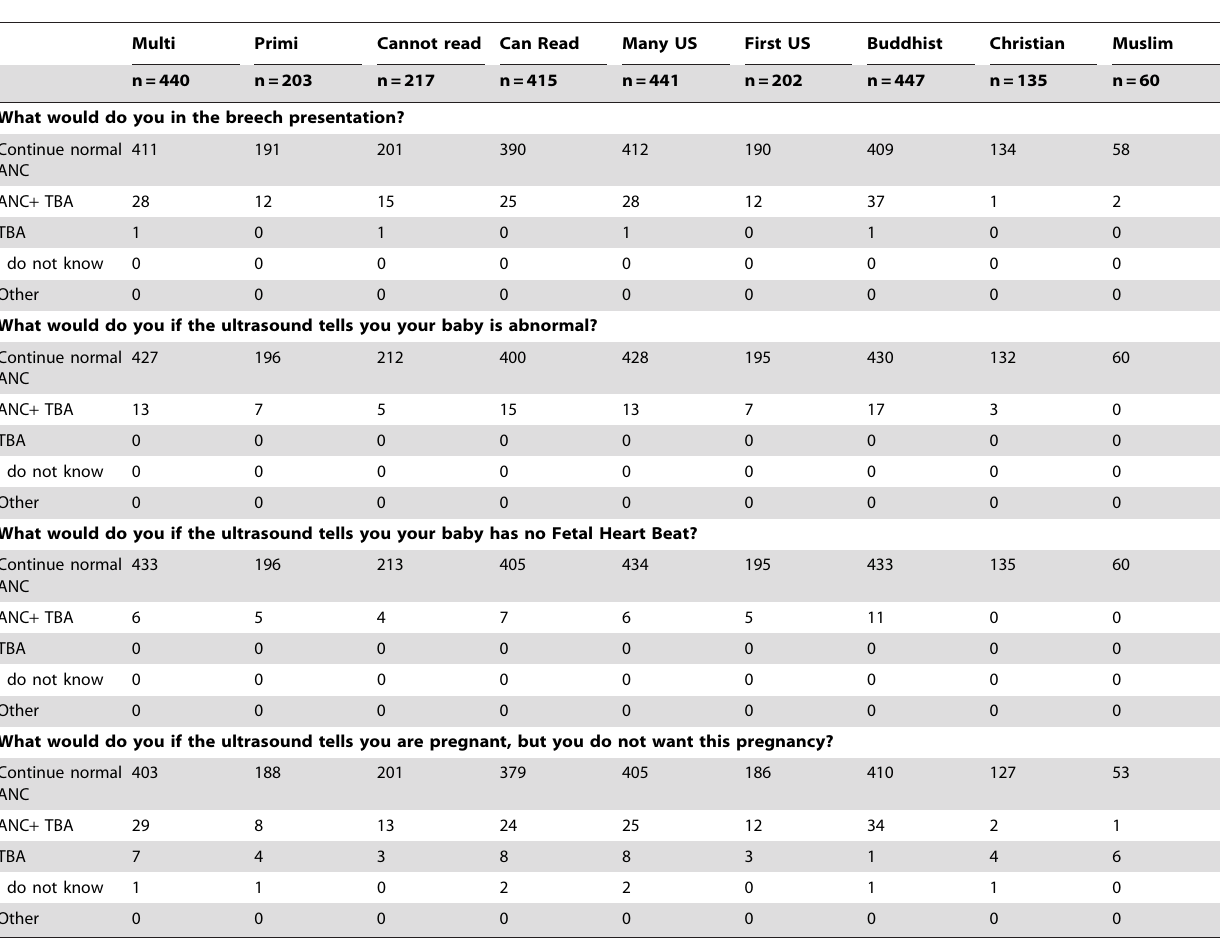
Table 3. Responses to ‘‘what would you do if?’’ questions in a questionnaire among 644 pregnant women on the Thai Burmese